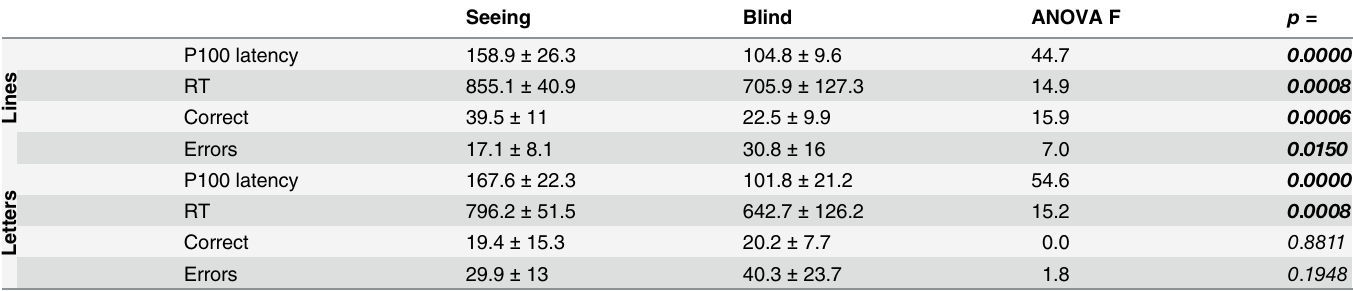
Table 2. Behavioral Performance on Tactile Recognition Tasks. Values provided represent mean and standard deviations for reaction times, successes and errors on line orientation and letter recognition tasks.